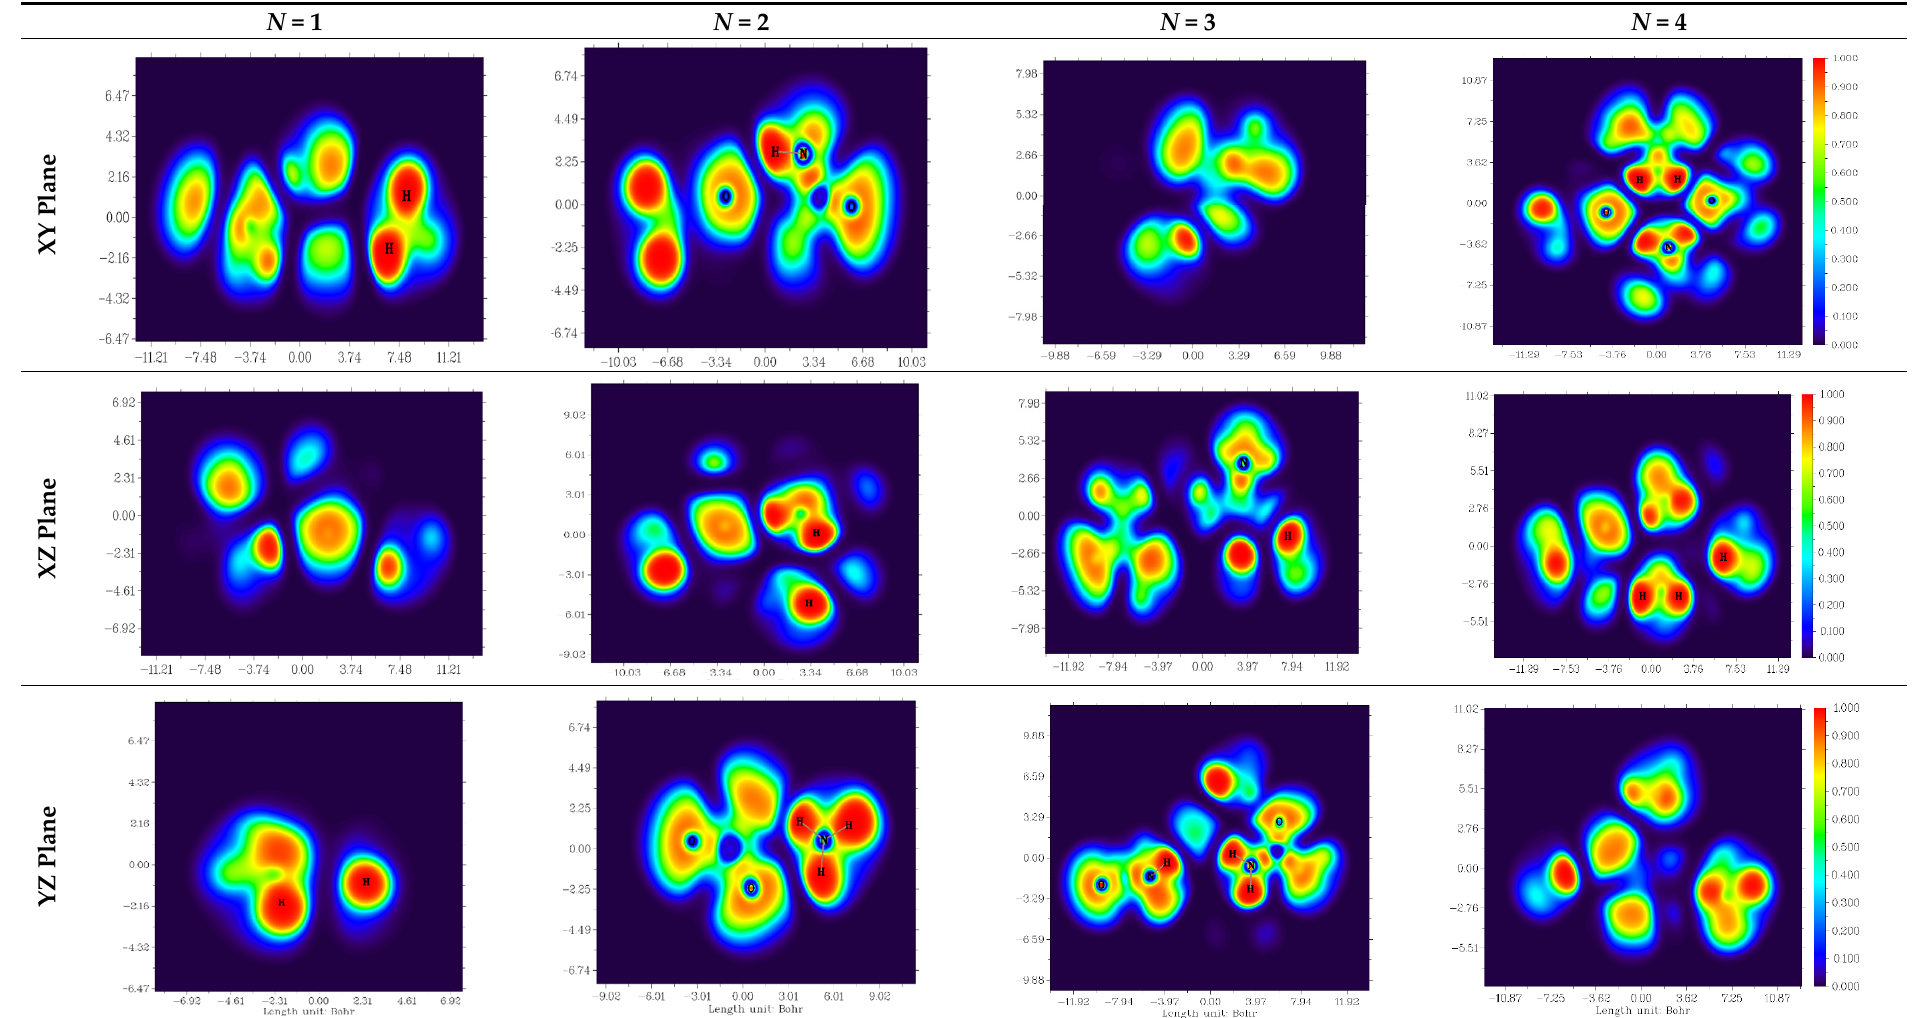
Figure 11. ELF colored maps for the investigated system.